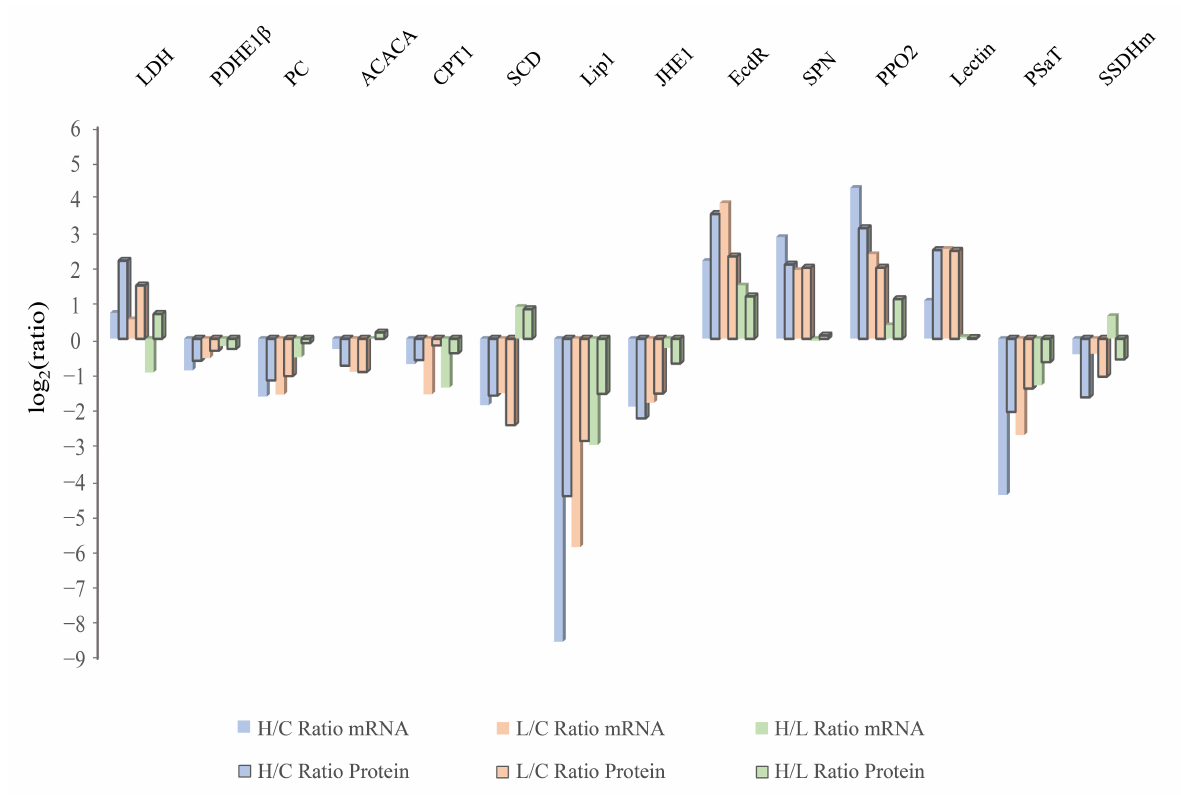
Figure 6. Transcription detection of target genes. Relative quantitation RT-qPCR verified the mRNA level of genes correlated with fatty acids, carbohydrates, hormones, and amino acid metabolism. The log 2 (relative ratio) of target genes was used to assess the condition of gene regulation. Different colored columns represent different comparative levels. LDH: lactate dehydrogenase; PDHE1 β : pyruvate dehydrogenase E1 component subunit beta; PC: pyruvate carboxylase; ACACA: acetyl-CoA carboxylase; Lip1: Triacylglycerol lipase; CPT1: carnitine O-palmitoyltransferase 1; SCD: Acyl-CoA delta-9 desaturase; JHE1: JHE-like carboxylesterase 1; EcdR: Ecdysteroid regulated-like protein; SPN: pacifastin light chain-like serine proteinase inhibitor; PPO2: Prophenoloxidase-2; PSaT: phosphoserine aminotransferase; SSDHm: mitochondrial succinate-semialdehyde